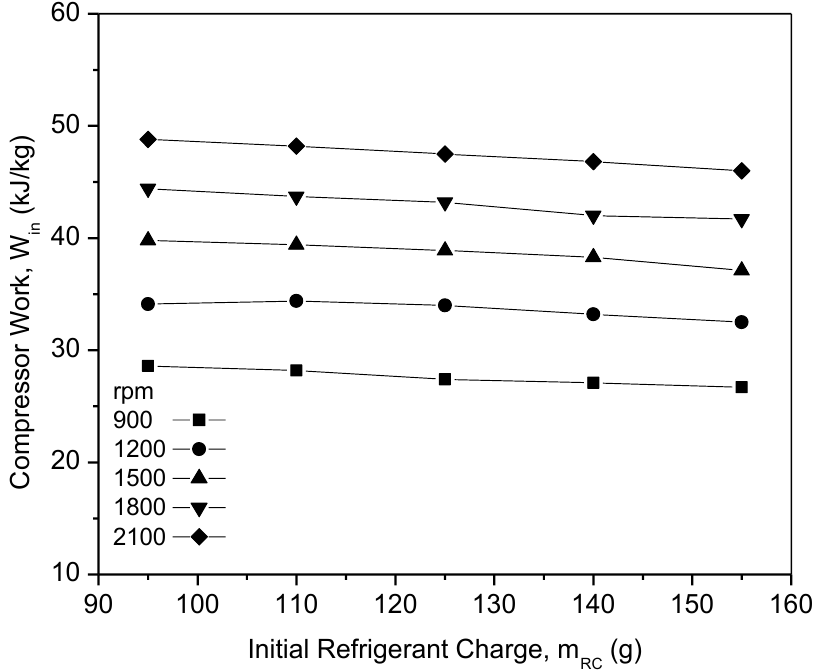
Figure 7. Compressor work of PAG at various refrigerant charges and compressor speeds.